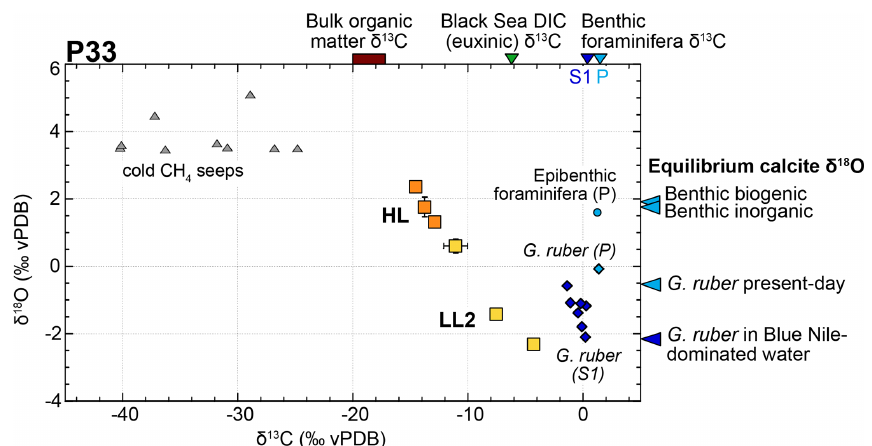
Figure 5. Isotopic signature of LL2 and HL from core P33. Scatter plot of δ 18 O vs. δ 13 C values of three LL2 (yellow) and three cemented HL (orange), as compared to isotopic signatures of methane-derived carbonates from the Nile DSF (grey triangles) (Aloisi et al., 2000; Bayon et al., 2013); P33 top-core and S1 planktonic foraminifera (light and dark blue diamonds, respectively); present and S1 epibenthic foraminifera (light blue circle and blue triangles; Grimm et al., 2015); P33 bulk organic matter δ 13 C (brown rectangle); Black Sea δ 13 C of dissolved inorganic carbon (DIC) (green triangle) (Fry et al., 1991); δ 18 O value of biogenic and inorganic benthic and planktonic calcite formed in equilibrium with seawater (blue triangles) (Table S4; see calculation details in the Supplement).